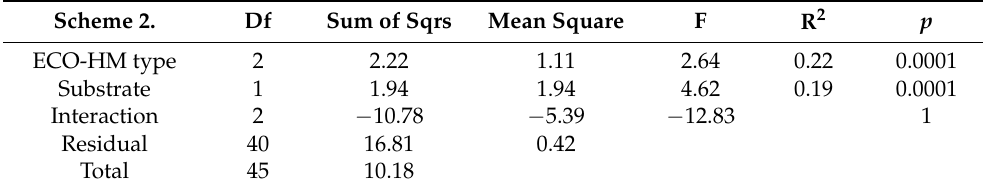
Figure 2. Nonmetric multidimensional scaling ordination diagrams of sampling sites. ( A ) Overlay indicates eco-hydromorphological types: intermountain ( (cid:3) ), lowland-braided (+), lowland-deep (o). ( B ) Overlay indicates coarse ( (cid:3) ) and fine (+) substrate. Stress (two-dimensional space) = 0.19. Table 3. PERMANOVA test of eco-hydromorphological types of large rivers and substrates and their interactions. ECO-HM—eco-hydromorphological river type, Df—degrees of freedom, p —probability of statistical significance based on 9999 permutations of the